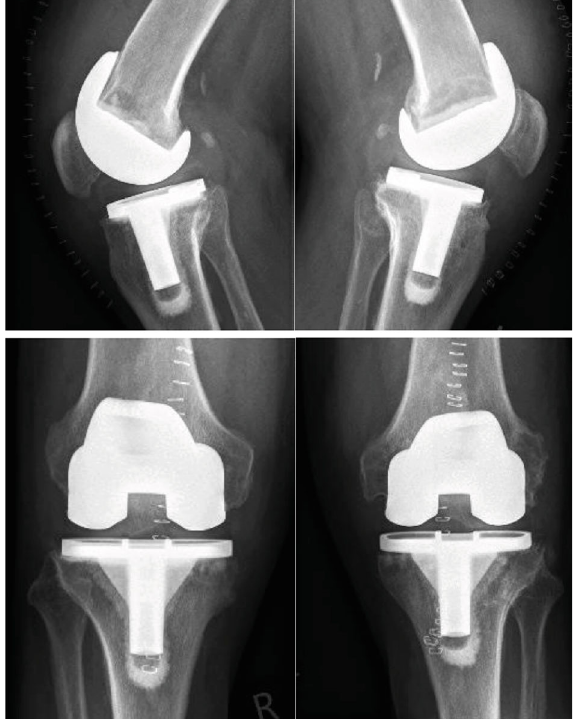
Figure 2: Radiographs in 2 planes directly after the implant- retaining procedure on both sides10 years after TKAs: no hint for loosening and clip